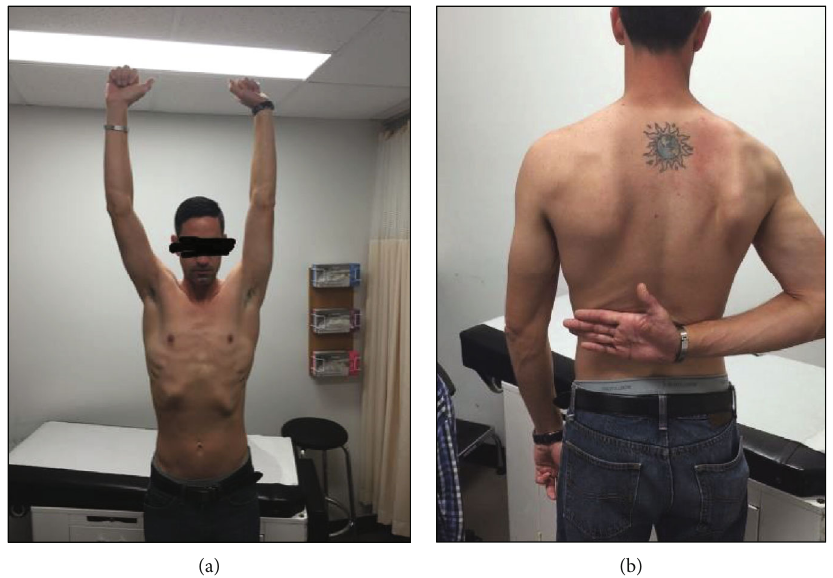
Figure 4: Final range of motion in abduction and anterior elevation (a) and internal rotation (b).